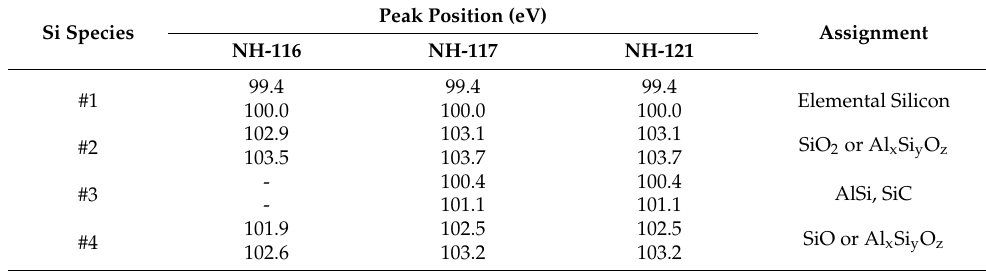
The peak fitting of the Si 2p core line spectra indicates the presence of four different types of silicon bonds near the sample surface. The assignments of these peaks are given in Table 2. The data for the spin-orbit splitting were obtained with a doublet separation of 0.61 eV and